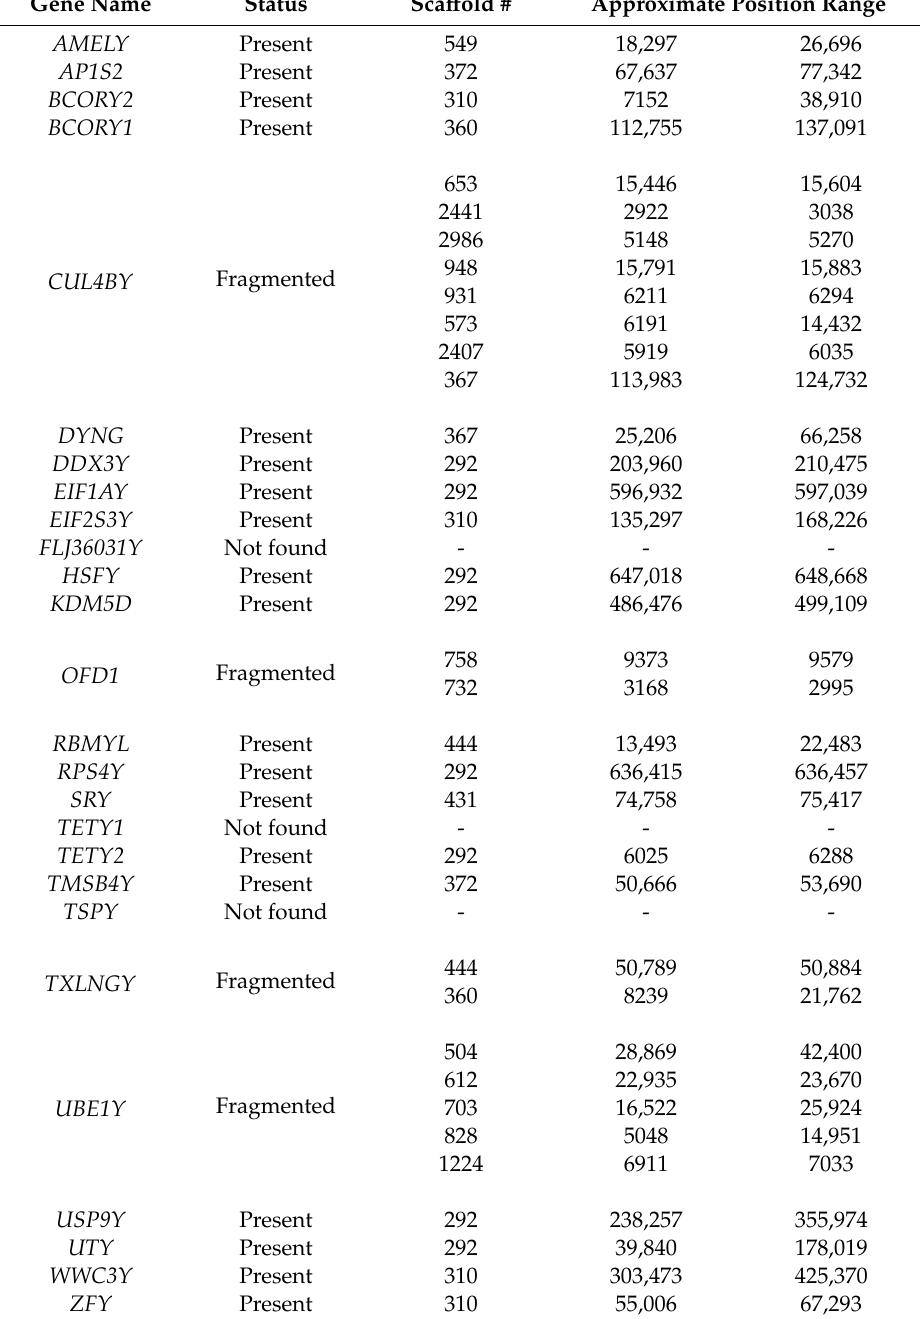
Table 3. Positions of carnivore MSY genes on the red fox sca ff olds. The approximate positions of each gene in the red fox genome was determined with